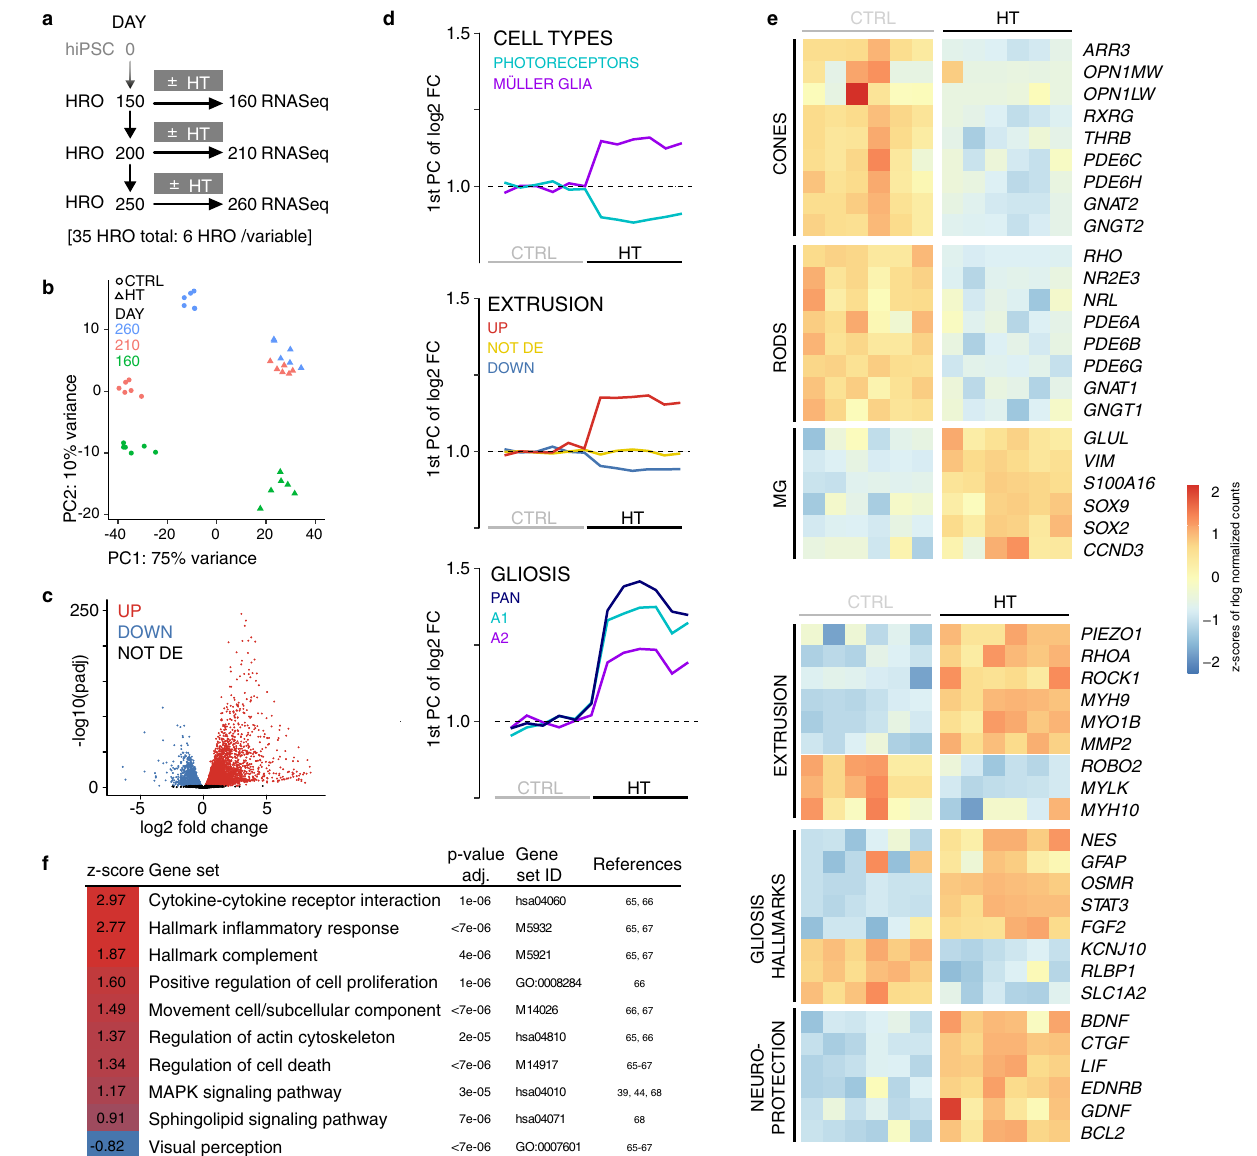
Fig. 7 | HT-HRO model transcriptomics indicates distinct pathologic processes and candidate regulators. a Experimental design: RNA-seq was performed on individual HROs after daily treatment with HBEGF-TNF (HT) for 10 days or with no treatment(CTRL),andatthreedifferentorganoidages. b Principalcomponent(PC) analysis of the rlog-transformed count data. c Volcano plot shows statistical sig- ni fi cance ( − log10 of the adjusted P values) in the magnitude of change (log2FC values) of the differentially- (DEG; red and blue) and non-differentially (black) expressed genes between HT and CTRL (D210, FDR 0.01). d Graphs depicting the 1st PC of the log2-fold change in CTRL and HT-HROs (D210) for custom-made genes-of-interest (GOI) lists based on published data (Supplementary Data 4),